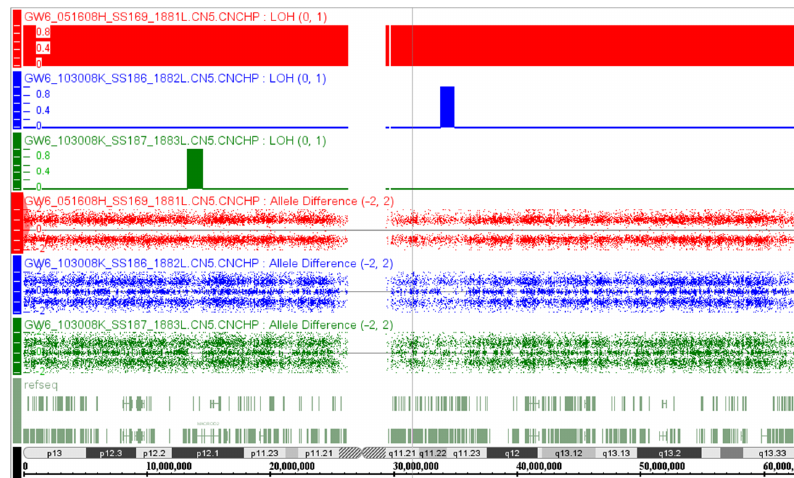
Figure 2. SNP array findings for chromosomes. Analysis of genomic DNA from the patient and his parents was performed using Affymetrix 6.0 array and identified loss of heterozygosity in the proband ( red ) compared to his mother ( green ) and the father ( blue ). Regions of LOH greater than 3 Mb are summarized in the red block. Note that the LOH in the proband extends across the entire chromosome 20. These data further validated the presence of uniparental disomy of the entire chromosome 20 in the BWS proband. Genes 2021 , 12 , x FOR PEER REVIEW